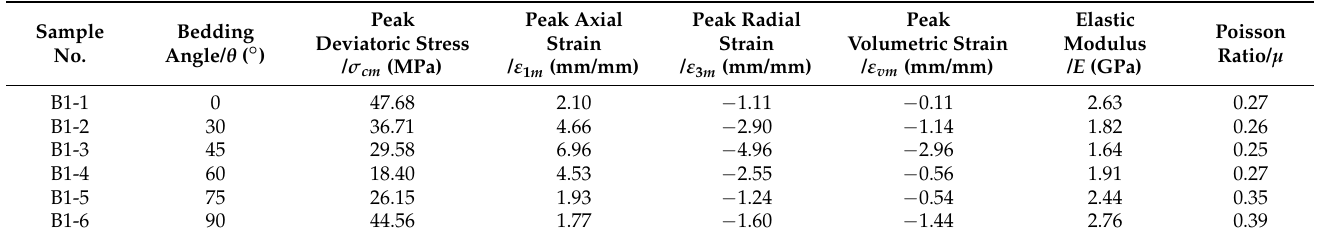
Table 3. Mechanical test results of samples with different angles at 9